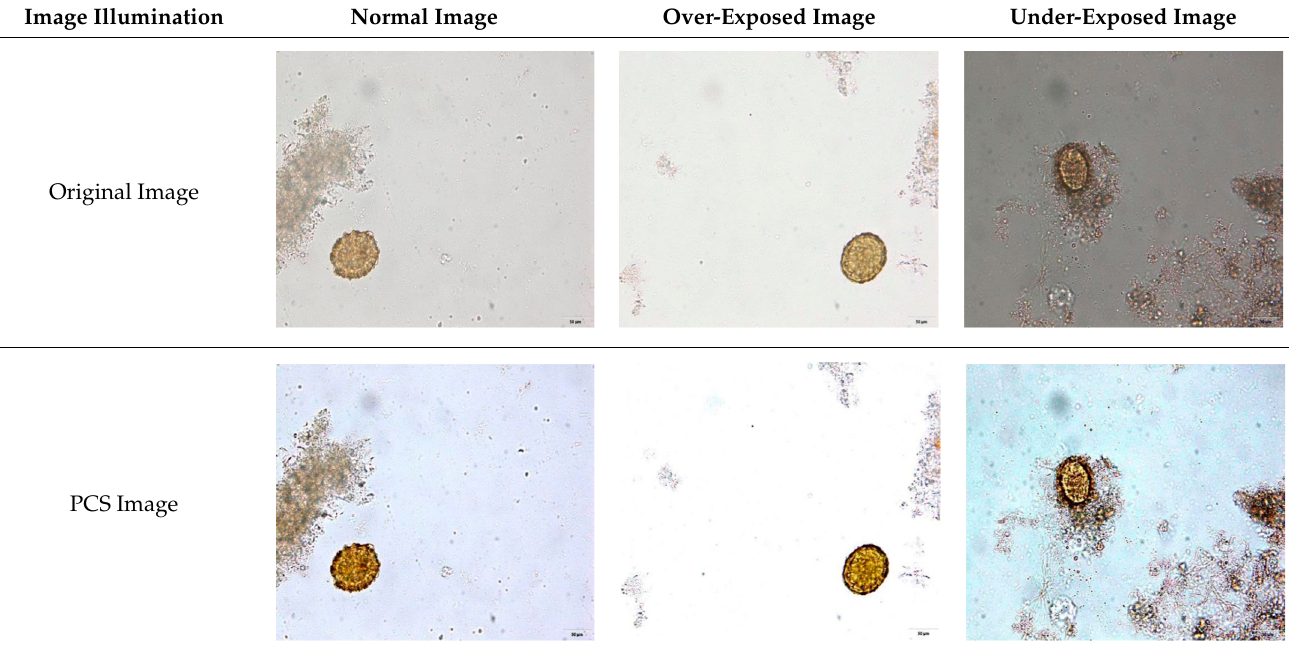
Table 2. The ALO image before and after implementing PCS technique. Scale bar = 50 µ m.